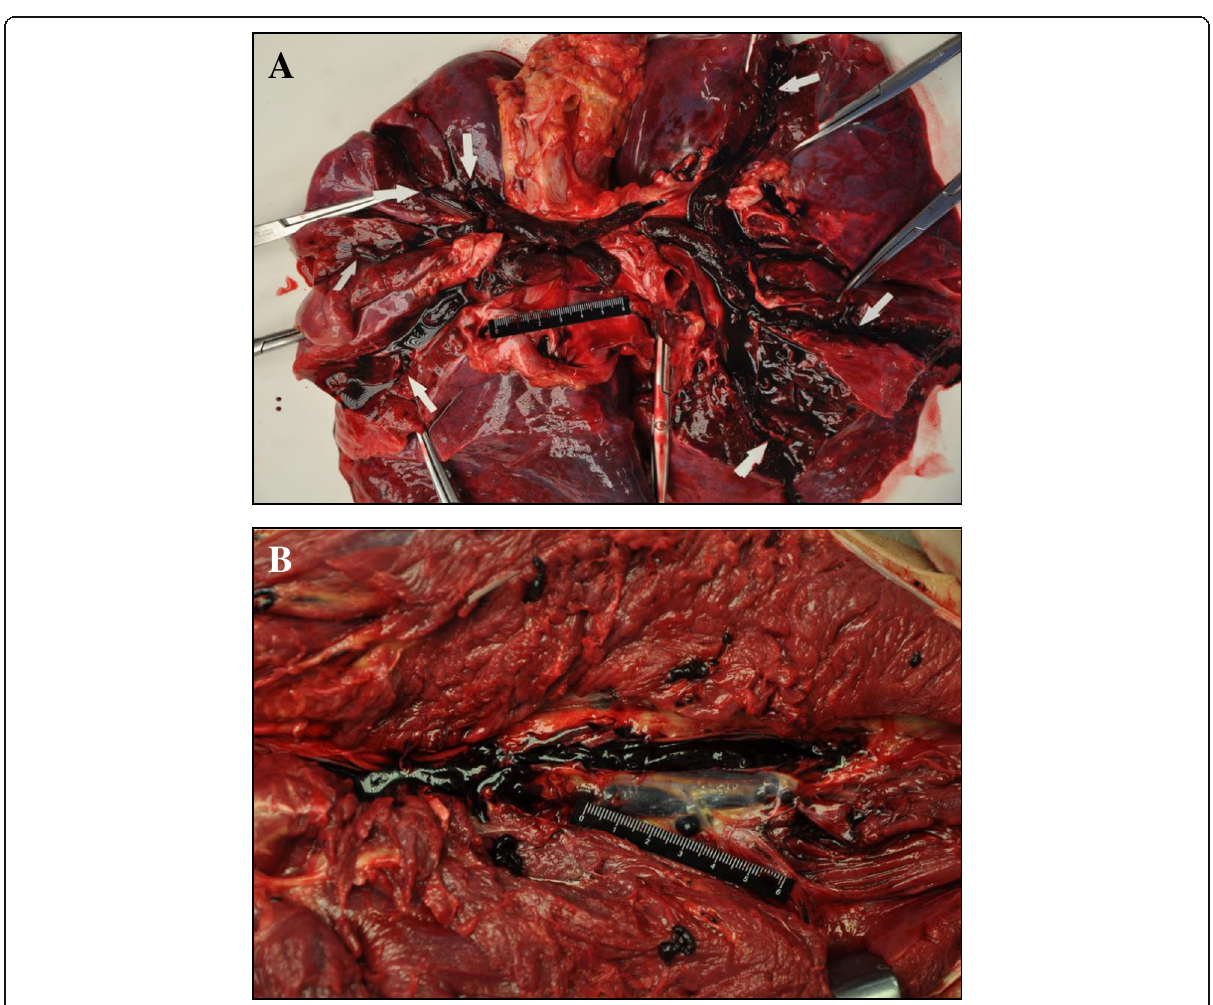
Fig. 1 Macroscopic images of the lungs and deep veins. a Large filamentous thromboembolic masses with coarse surfaces filled the pulmonary trunk and both pulmonary arteries. b Dark red thrombi in the deep